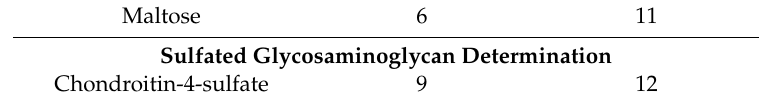
Table 2. Quantification of the sugar content of the soluble shell matrix of A. hians . The upper panel depicts the total sugar quantification (based on two standards, glucose, and maltose) while the lower one indicates the concentration of sulfated glycosaminoglycans (GAGs). Total Sugar Determination % of the Whole Matrix Standard % min % max Glucose 4 10.7 15 of 33 Maltose 6 11 Sulfated Glycosaminoglycan Determination Chondroitin-4-sulfate 9 12